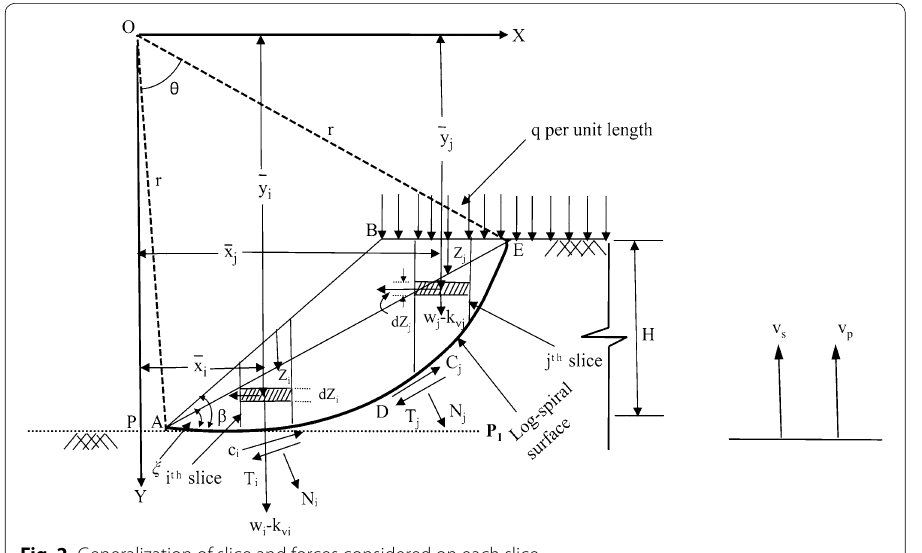
Fig. 2 Generalization of slice and forces considered on each